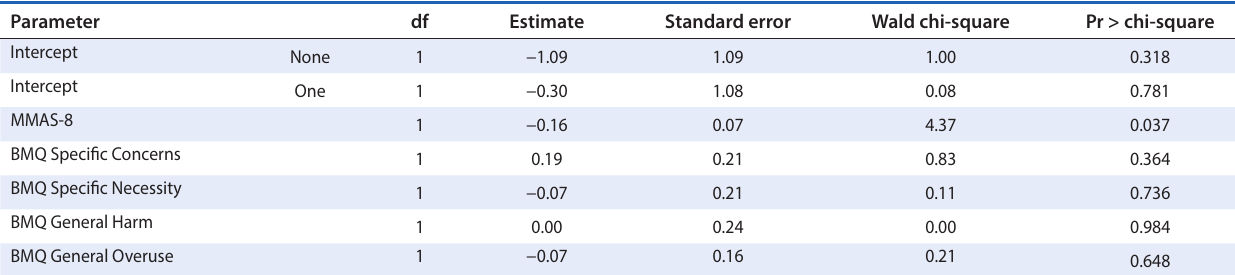
Note: df = degrees of